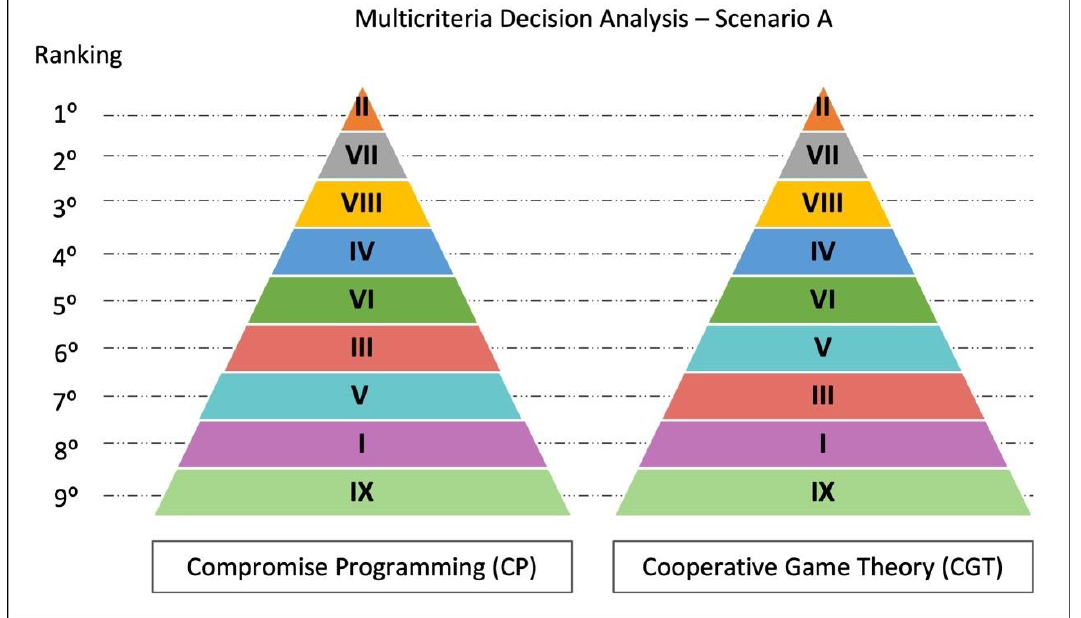
Figure 5. Hierarchy generated by CP and CGT methods to choose the most favorable profile, ac- cording to the 13 criteria for Scenario A. according to the 13 criteria for Scenario